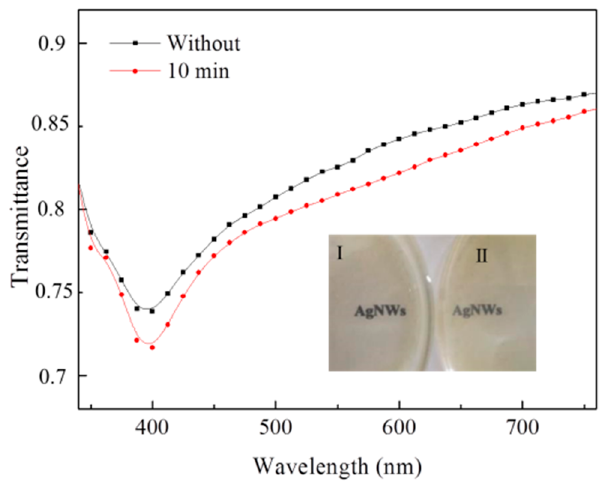
Figure 2. Transmittances of Ag nanowires before and after 10 min ultrasonic treatment. Inset image is the optic images of the Ag nanowire suspension before and after 10 min ultrasonic treatment.